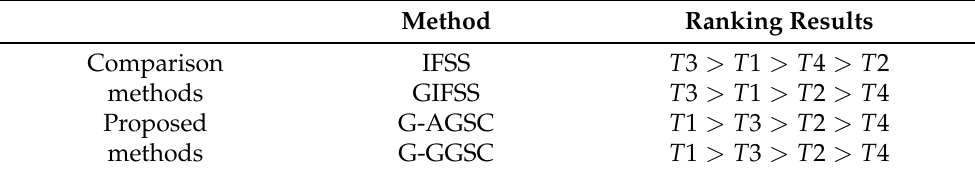
Table 7. Ranking results of the targets under different methods in the proposedindex